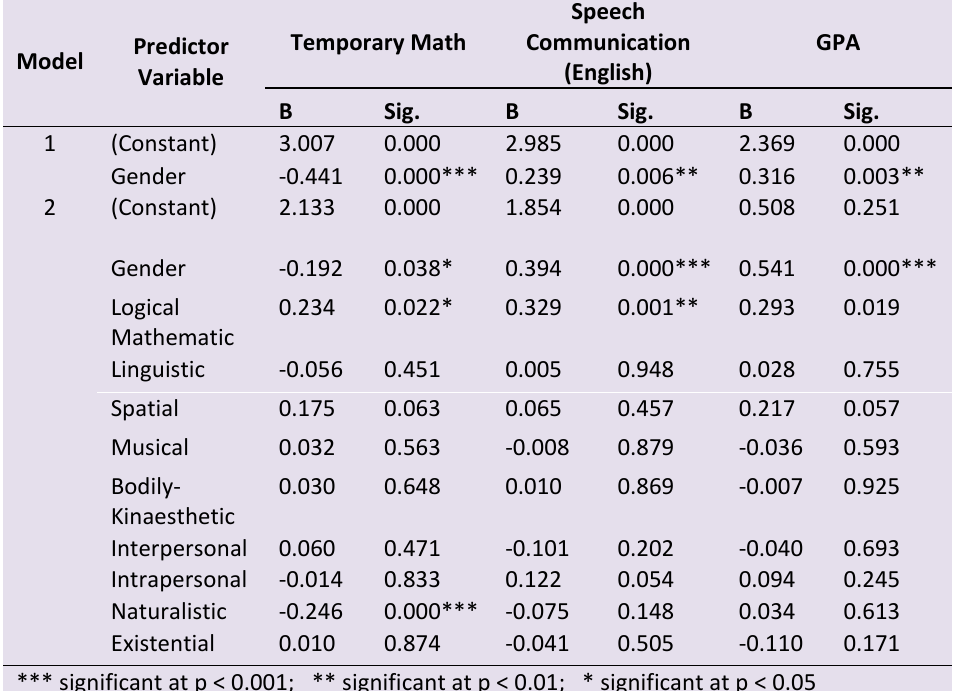
Table 7. Result of hierarchical regression among gender and multiple intelligence toward performance Speech Temporary Math Communication Predictor Model Variable